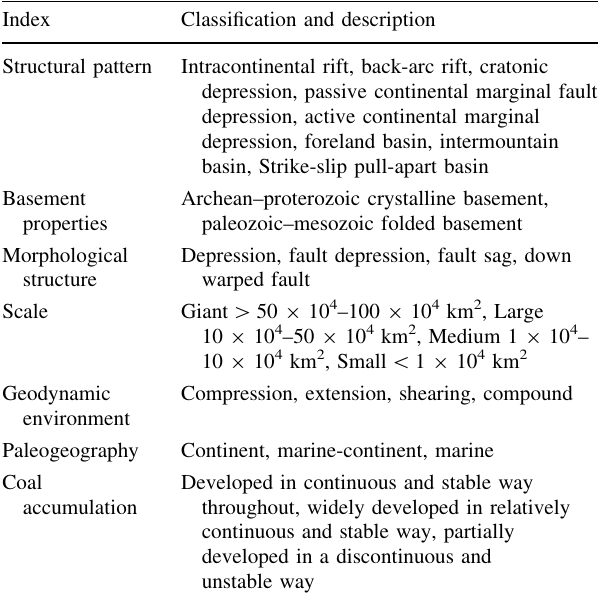
Table 2 Classification index of coal-forming